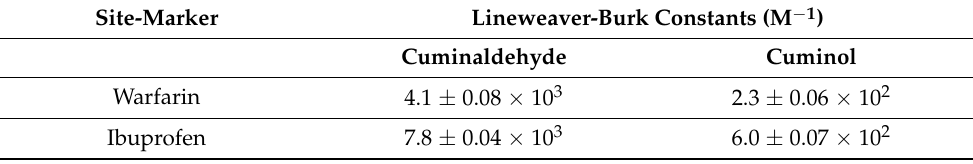
Figure 8. Lineweaver-Burk plots of ( A ) HSA–cuminaldehyde and ( B ) HSA–cuminol systems in presence of warfarin or ibuprofen. Table 5. Lineweaver-Burk constants for the interaction of HSA with cuminaldehyde/cuminol in the presence of site